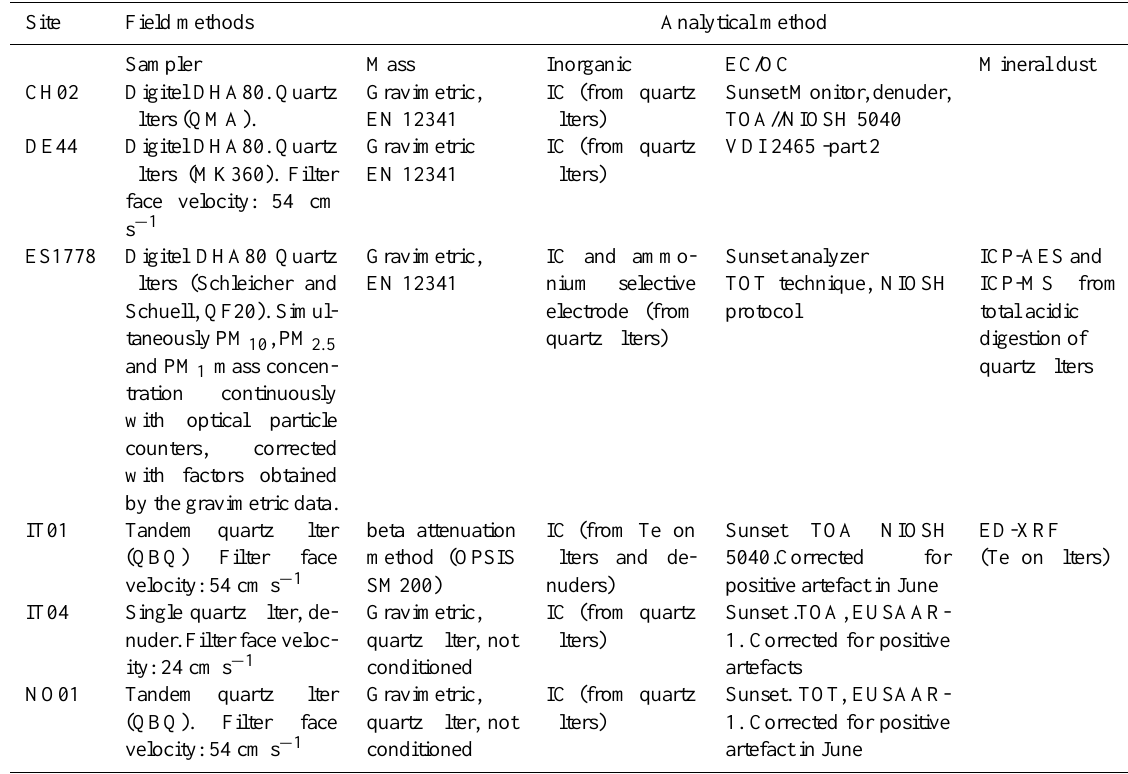
Table 2. Methods in field and laboratory for sites with chemical composition of daily measurements (manual method) in PM 10 and PM 2 . 5 of inorganic and organic